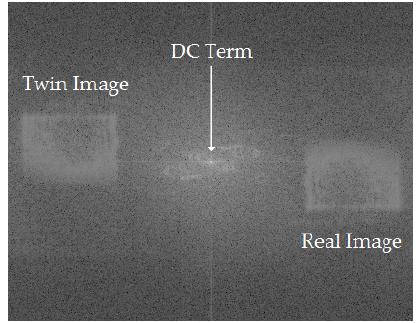
Figure 2. Example of experimentally derived interferogram collected by Cavan